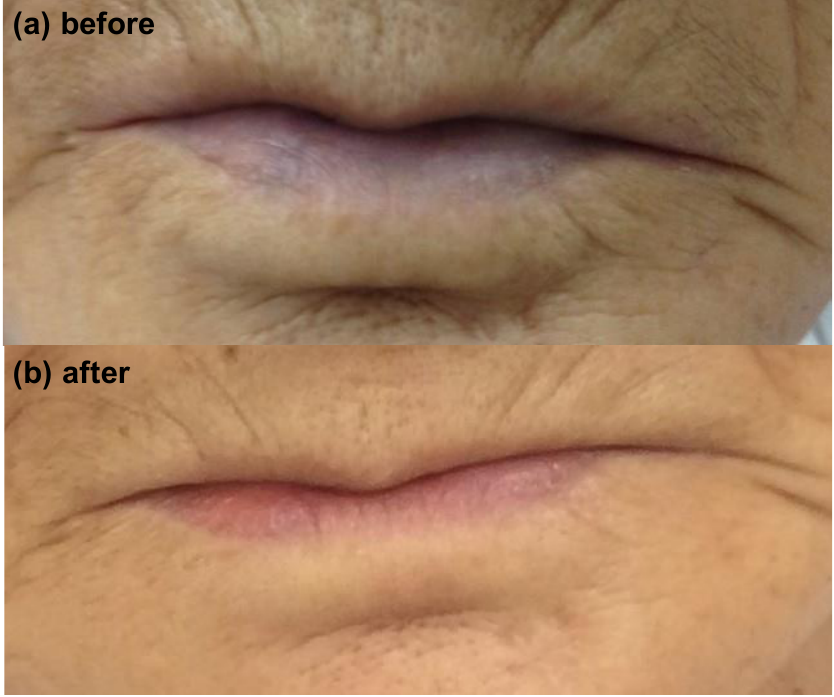
Figure 5. Lips of the patient before ( top , showing cyanosis) and after ( bottom , no cyanosis) the administration of methylene blue.